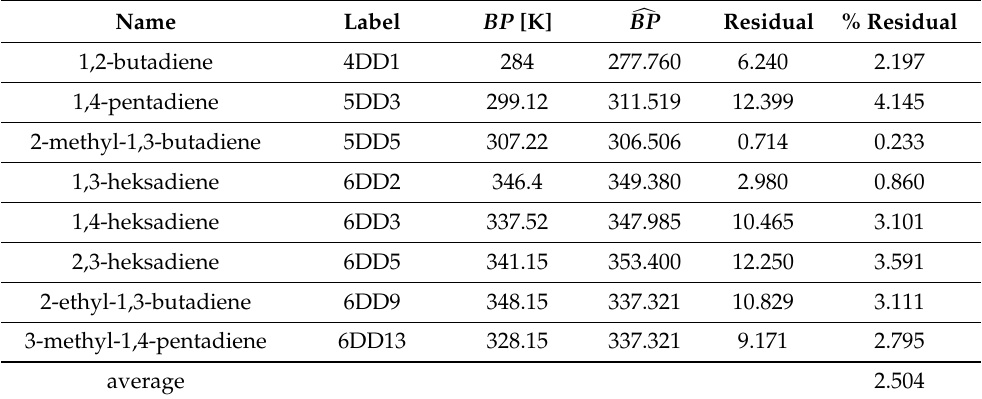
Table 6. Data for the alkadienes in the test